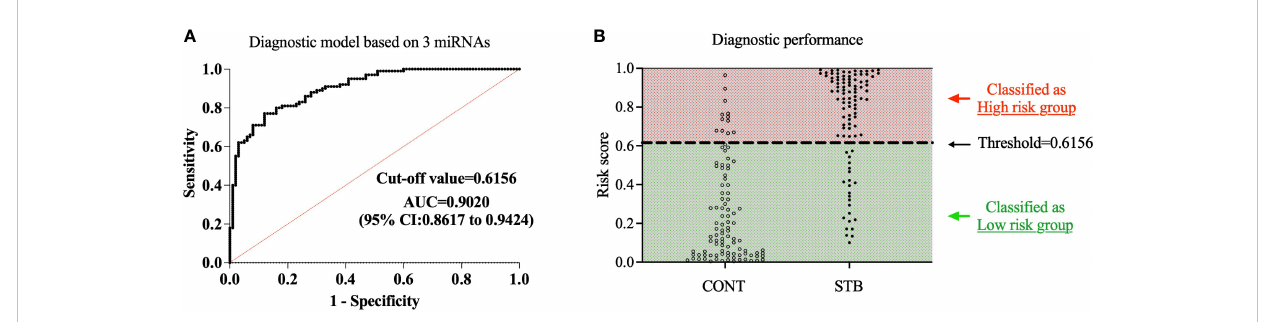
FIGURE 3 Development of diagnostic model based on a three miRNA signature. A diagnostic model for STB was developed using multivariate logistic regression based on the expression levels of 3 selected miRNAs as variables. (A) . The diagnostic accuracy of the diagnostic model was assessed by ROC analysis. (B) . The samples were divided into high-risk and low-risk groups based on the cutoff value of the diagnostic model; the population of CONT and STB groups was then classi fi ed into high-risk and low-risk